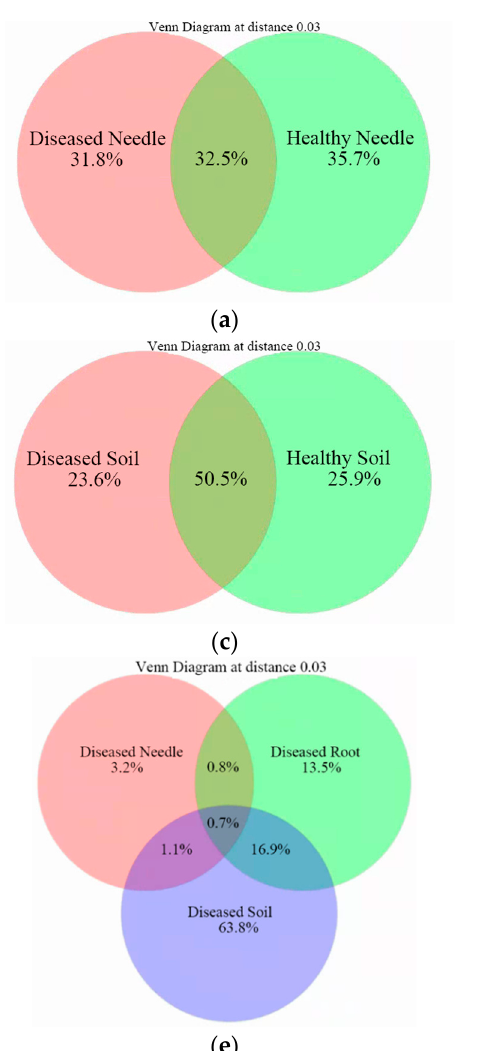
Figure 3. Venn diagram showing the unique and shared operational taxon units (OTUs) between healthy and diseased samples in the needles ( a ), roots ( b ), and soil ( c ), and among the needles, roots, and soil in healthy ( d ) and diseased ( e ) samples.